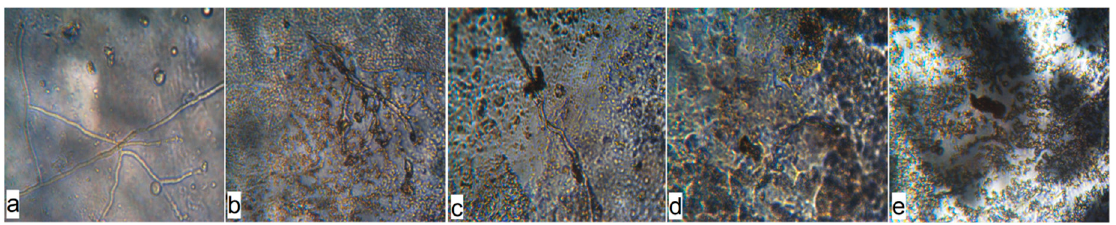
Figure 8. Microphotographs of the surface of the inoculated polyethylene materials with birch bark extract and with the use of ultrasonic treatment on the 14th day of A. niger exposure (100 × magnification): ( a ) PE 0% BBE ultrasound; ( b ) PE 0.5% BBE, ultrasound; ( c ) PE 1.0% BBE, ultrasound; ( d ) PE 2.0% BBE, ultrasound; ( e ) PE 5.0% BBE, ultrasound.